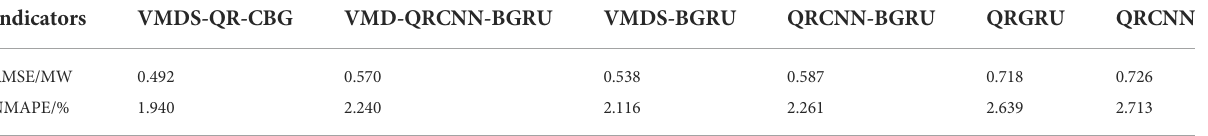
TABLE 5 Deterministic predication error statistics of different